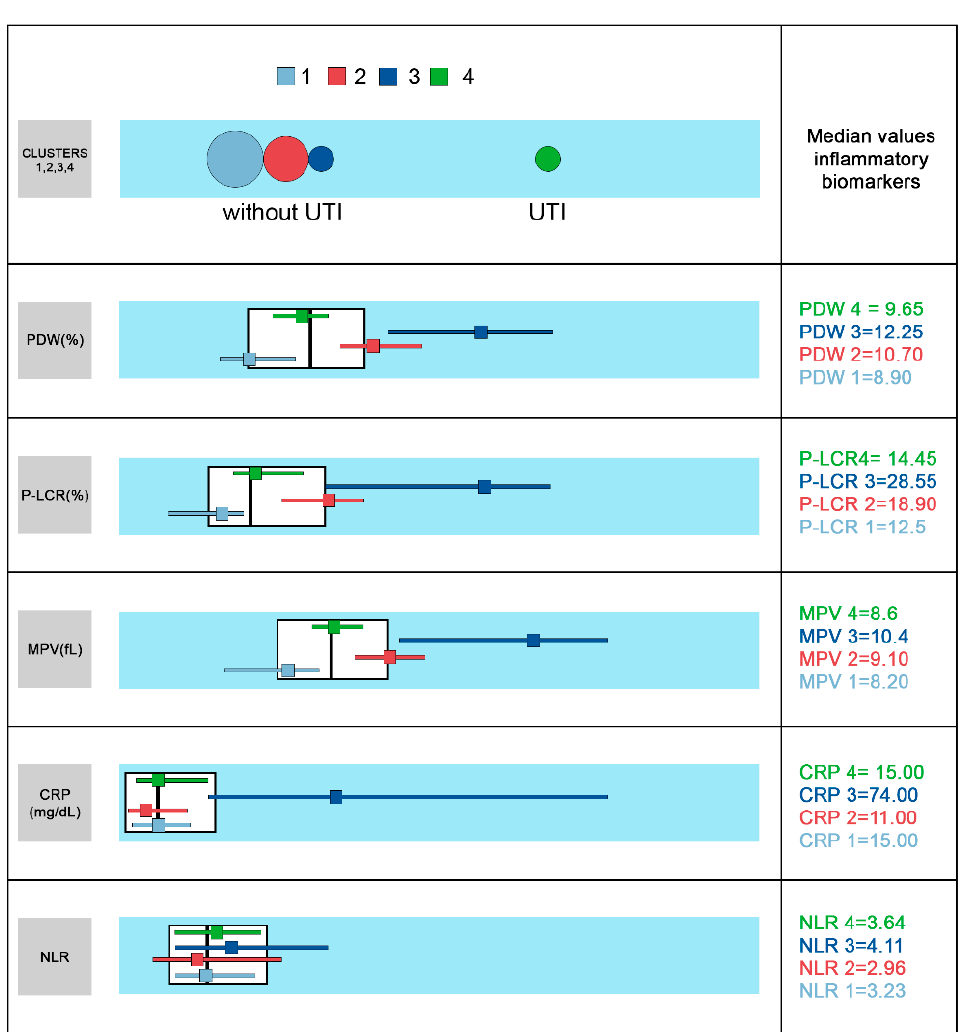
Figure 1. Two step cluster analysis for the whole cohort of patients, using as segmentation variables the proposed inflammatory biomarkers. Clusters 1, 2, 3, and 4 are color-coded and the median values for PDW (%), P-LCR (%), MPV (fL), CRP (mg/dL), and NLR are accordingly presented for each cluster.